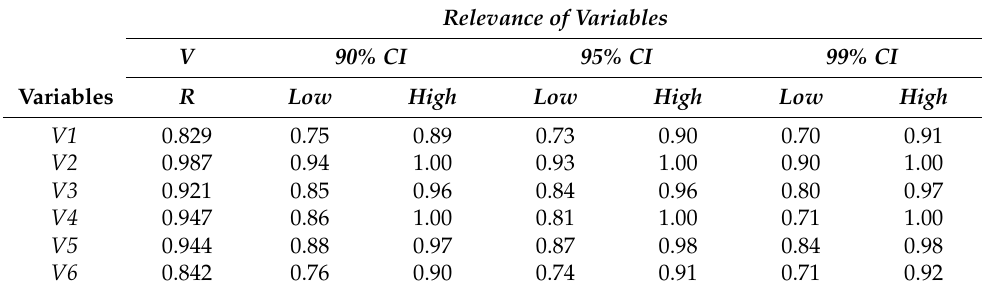
Table 4. Aiken’s V coefficient values and confidence intervals for each of the relevance of variables results. Relevance of Variables